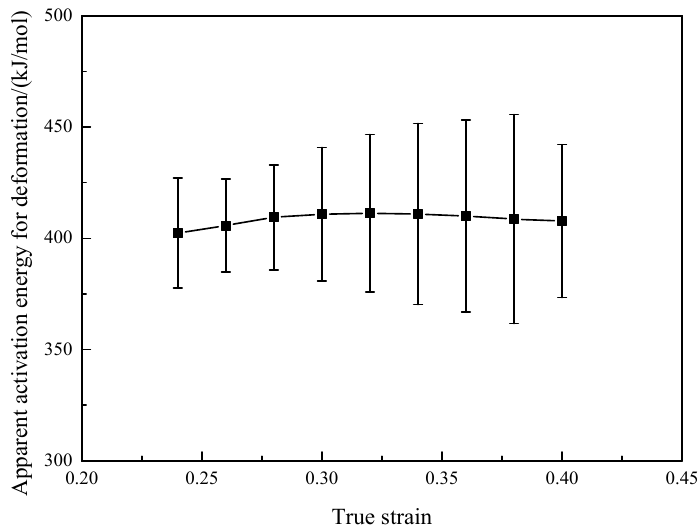
Figure 8. Apparent activation energy for deformation of the GH3230 superalloy double-sheet in hot tensile tests.